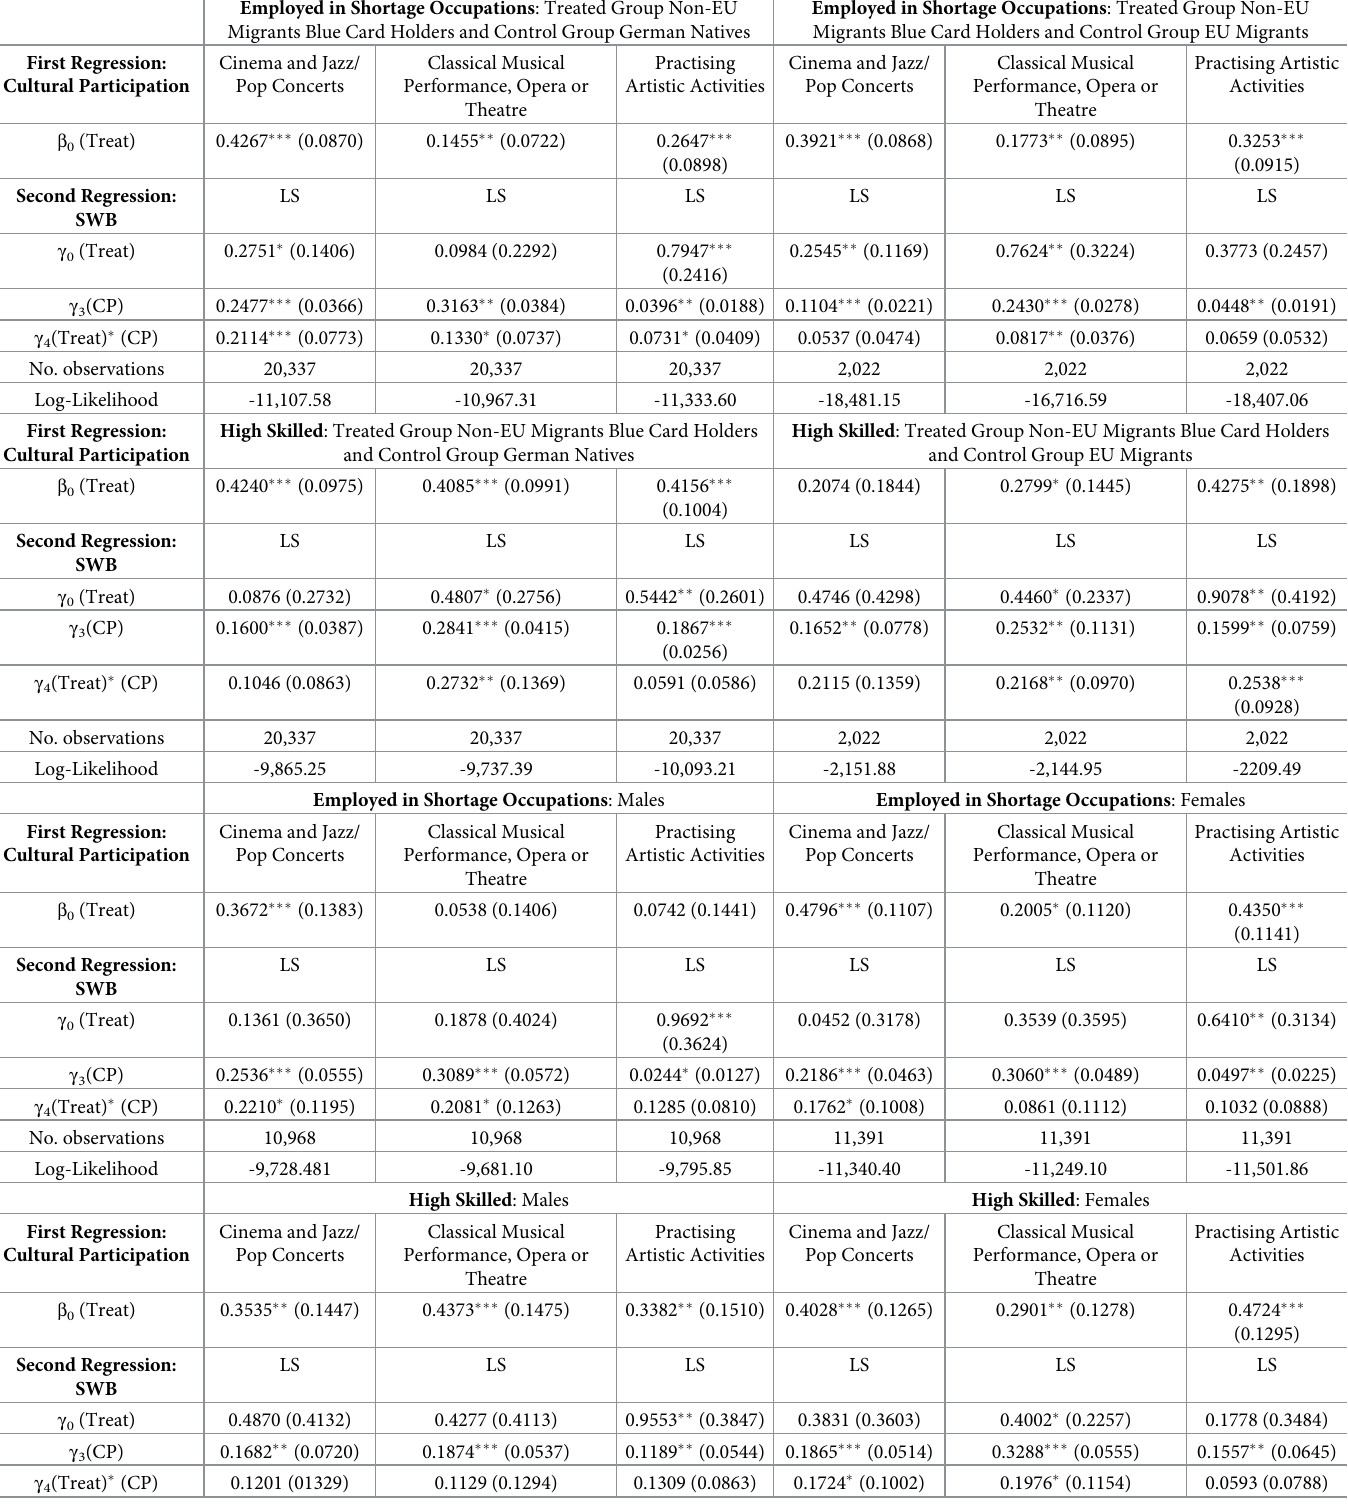
Table 12. Ordered Probit SURE FRDD robustness